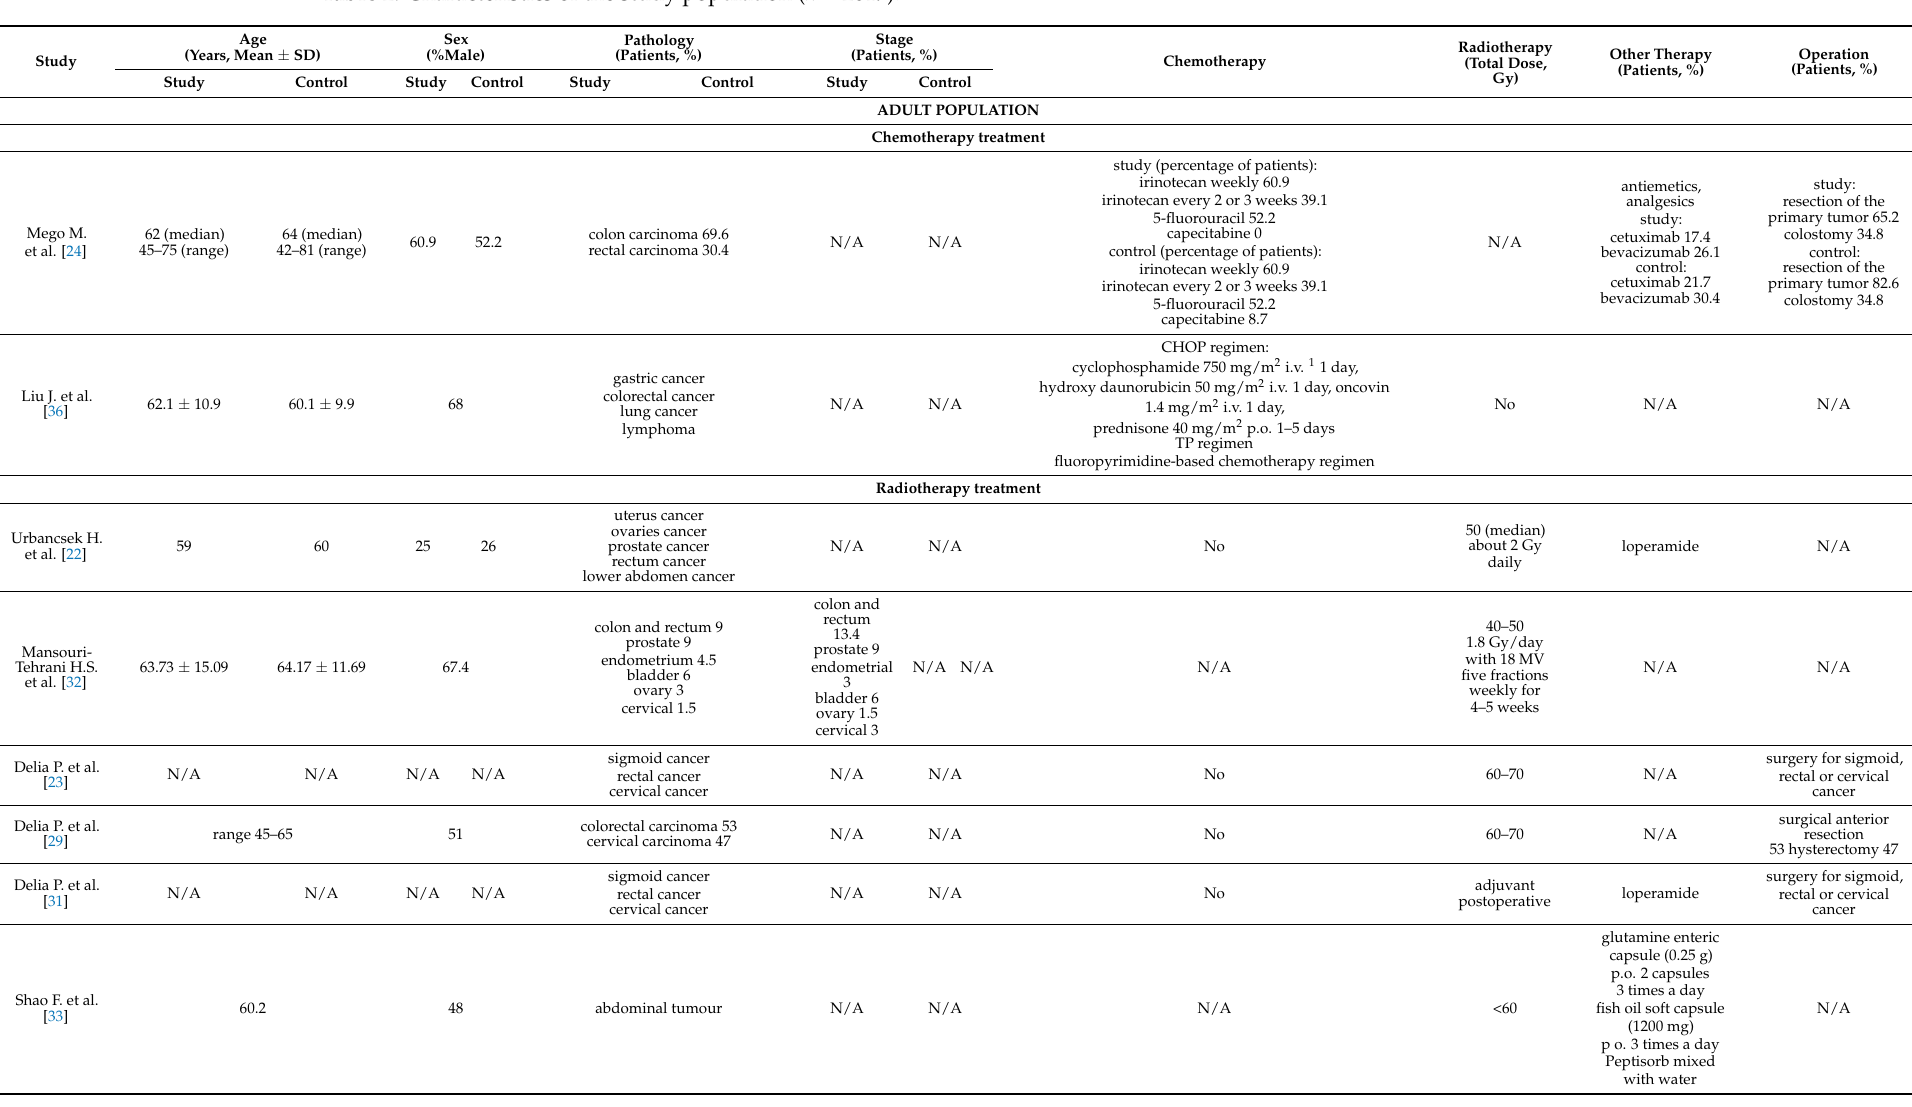
Table 2. Characteristics of the study population ( n =